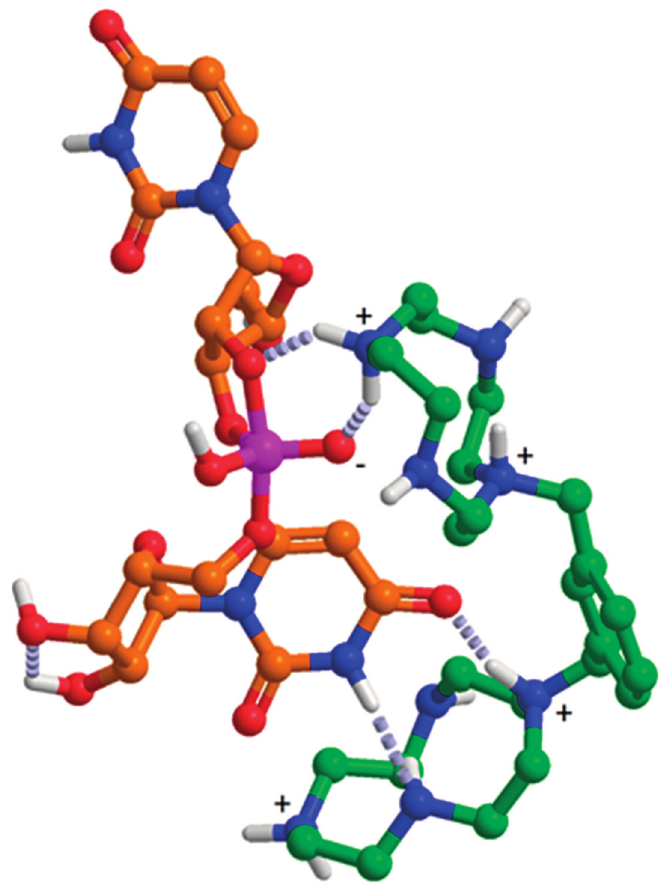
Figure 5. MOPAC (PM6)-minimized structure for tetracationic 11b (green) hydrogen bonded (dashed lines) to the monoanionic, pentacoordinate intermediate (orange) of UpU cleavage and